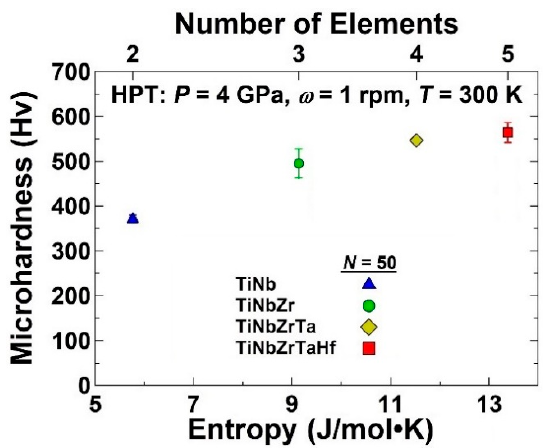
Figure 3. Variation of hardness versus configurational entropy for TiNb, TiNbZr, TiNbZrTa and high-entropy alloy TiNbZrTaHf, synthesized by high-pressure torsion, reproduced from [78], with permission from ELSEVIER, 2021. Grain size, dislocation density and atomic-size-mismatch parameters were similar for ternary, quaternary, and quinary alloys.